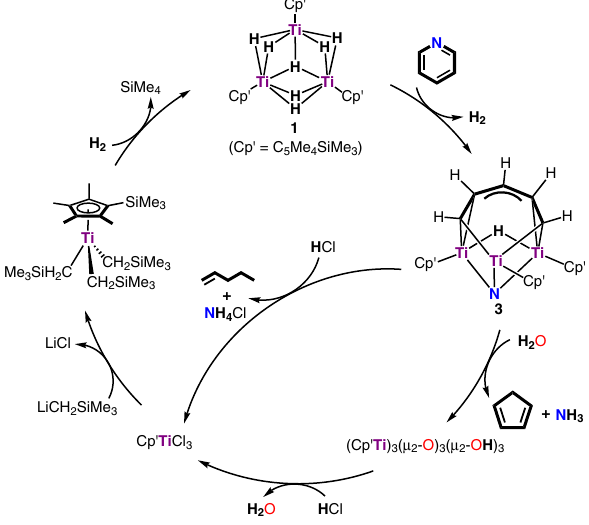
Fig. 6 Titanium-mediated cycles for the hydrodenitrogenation of pyridine by H 2 . The reaction of pyridine with 1 gave 3 with the release of H 2 . Treatment of 3 with HCl afforded 1-pentene, NH 4 Cl, and Cp ′ TiCl 3 , while the reaction of 3 with H 2 O yielded cyclopentadiene, NH 3 , and (Cp ′ Ti) 3 ( µ 2 - O) 3 ( µ 2 -OH) 3 which upon treatment with HCl gave Cp ′ TiCl 3 . The reaction of Cp ′ TiCl 3 with LiCH 2 SiMe 3 yielded Cp ′ Ti(CH 2 SiMe 3 ) 3 , which upon hydrogenolysis with